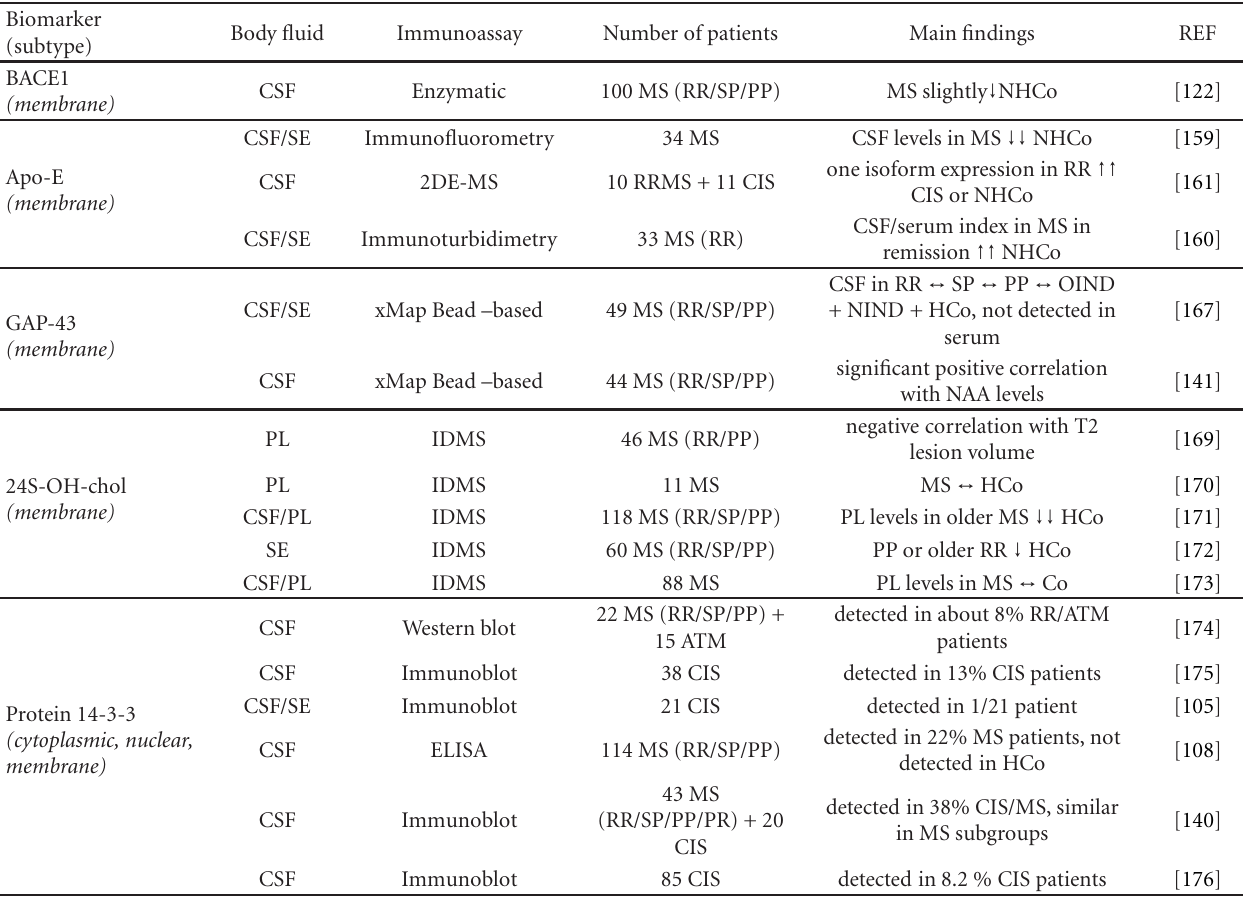
Table 5: Membrane and nuclear biomarkers of neuroaxonal damage in the cerebrospinal fluid (CSF) and blood of patients with multiple sclerosis (MS) and/or clinically isolated syndrome suggestive of MS